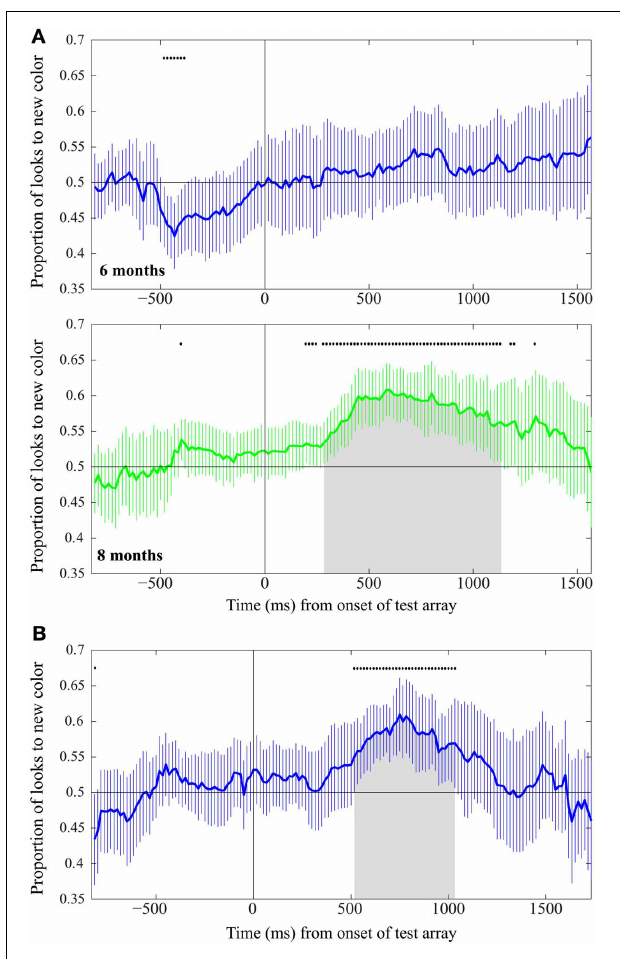
FIGURE 4 | The subject-weighted proportion of looks to the changed square (1 = 100% of all looks aggregated across subjects were to the changed square; 0 = 0% of all looks were to the changed square) by age and Experiment (Experiment 1 in panel A, Experiment 2 in panel B). For each observed sample during the sample and delay period ( − 833 to 0ms) and during the post-change period (0–1533ms for Experiment 1 and 0–1717ms for Experiment 2), the curve represents the mean responding and the vertical lines represent the 95% confidence interval for each sample. The dots above the curve indicate samples that were significantly different than chance (0.50), by an uncorrected two-tailed t -test. The shaded area under the curve marks runs of samples that pass the 95% run length